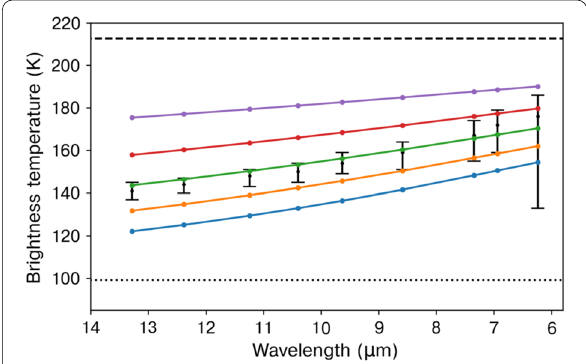
Fig. 10 Anisothermality of Tycho crater in the image taken on 2021/02/13 16:30, with a corresponding local time of 0.5 H. The black points are the brightness temperatures at the center of Tycho crater in HSD at every band. The black error bars are estimated from the background noise level in each image. The black dashed and dotted lines show surface temperature models of lunar rock and regolith in Tycho crater at the same local time, respectively. The blue, orange, green, red, and purple solid lines are predicted brightness temperatures of mixture models with rock ratios of 2.5, 5, 10, 20, and